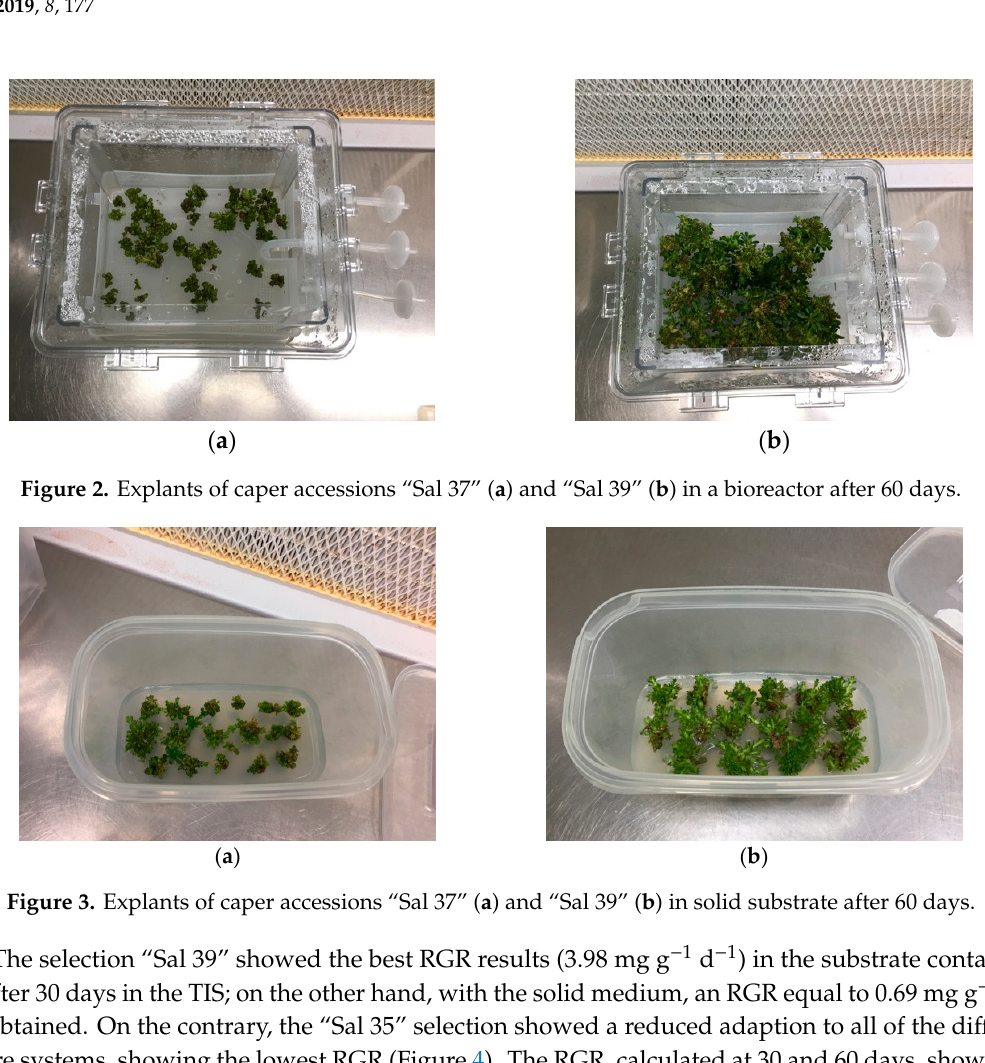
Figure 4. Relative Growth Rate (RGR) of different Capparis spinosa accessions after 30 ( a ) and 60 days ( b ) in different culture systems. Bars represent standard error. Abbreviations: A1 S: substrate A1 solid, A1 L: substrate A1 liquid; A2 S: substrate A2 solid; A2 L: substrate A2 liquid. The different letters reported above the bars grouped for each single treatment indicate statistically significant differences; n.s. not significant (Tukey’s test, p ≤ 0.05 ).